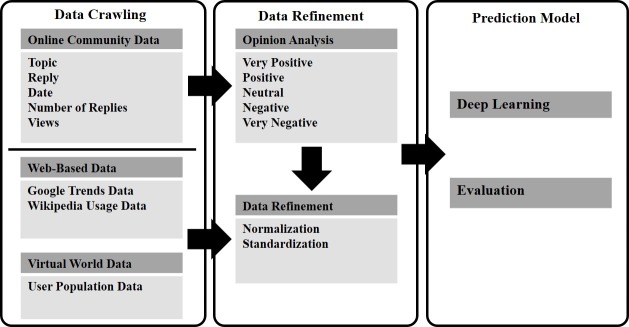
System overview.